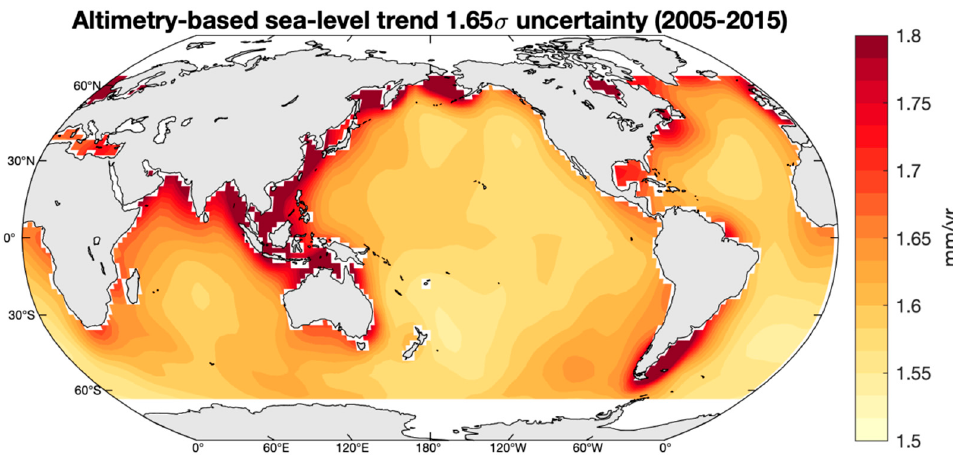
Figure 3. Uncertainty at 90% confidence level (i.e., 1.65 σ ) map for the altimetry-based sea-level trend [43] for the time interval January 2005–December 2015.